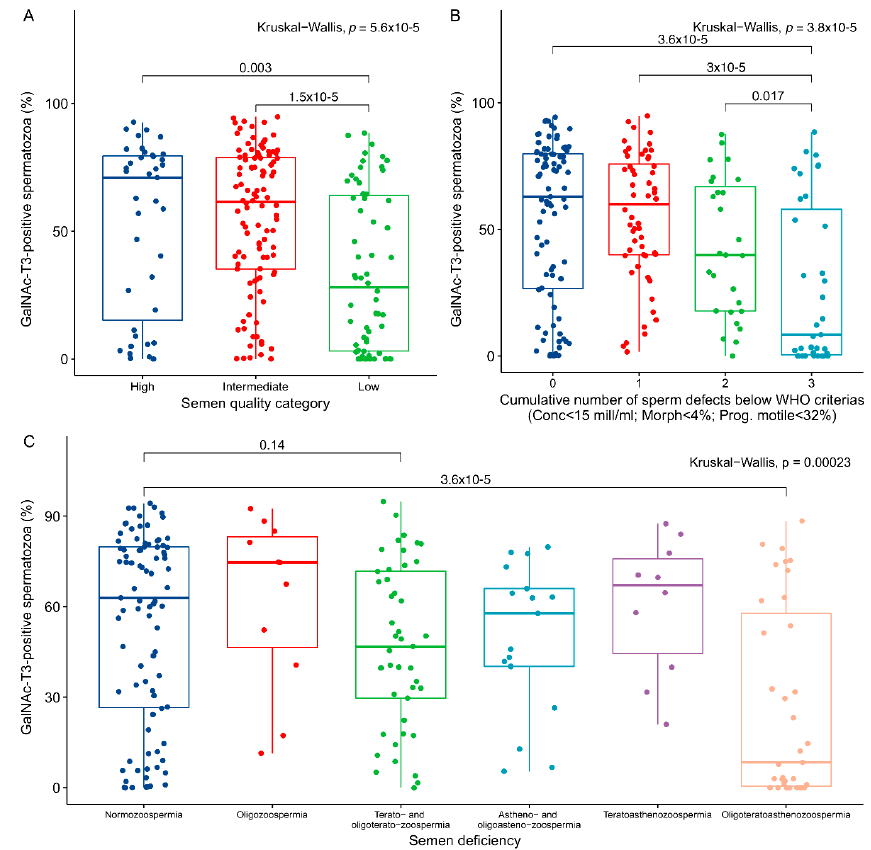
Figure 4. Association between GalNAc-T3 levels and semen quality. ( A ) The samples were divided into categories of high ( n = 39), intermediate ( n = 104), and low ( n = 62) semen quality based on parameters given previously [23] and plotted in a boxplot showing the fraction of GalNAc-T3-positive spermatozoa. ( B ) Boxplot of the fraction of GalNac-T3-positive spermatozoa and the cumulative number of sperm defects as defined by the World Health Organisation (WHO). ( C ) Boxplot of the fraction of GalNAc-T3-positive spermatozoa and the type of semen deficiency observed. p -values from comparisons of individual groups by Wilcoxon rank sum tests, as well as the overall significance of the grouping by Kruskal-Wallis tests are indicated on each plot.